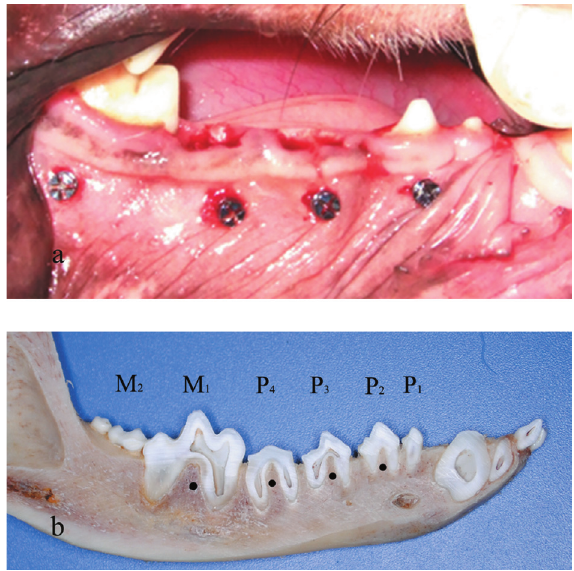
Figure 1- Images illustrating placement sites of microscrews in the mandible of beagle dogs. (a) Clinical picture of microscrews in mandible. (b) Transverse section of mandible with black dots indicating the precise site of